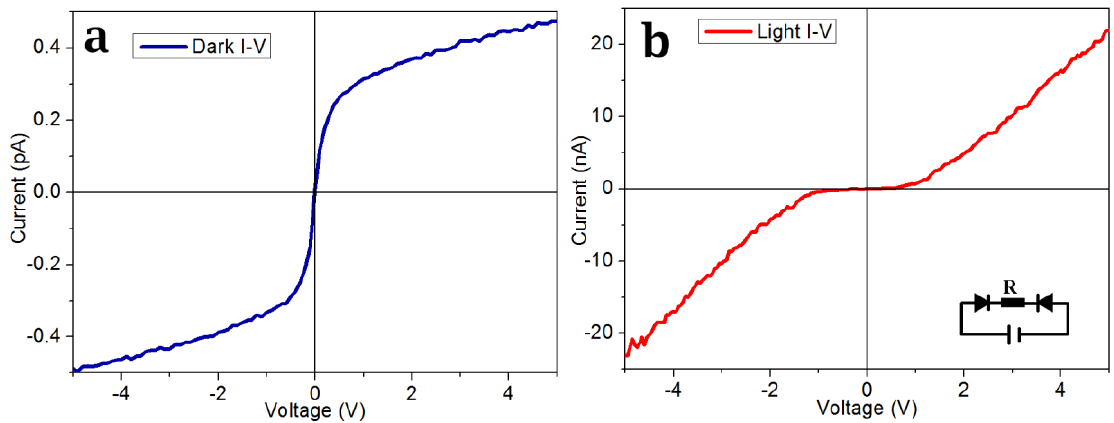
Figure 5. I-V curves of the device: ( a ) was the I-V curve without light illumination; ( b ) was the I-V curve with light illumination; the lower right insert of b was the schematic diagram of the